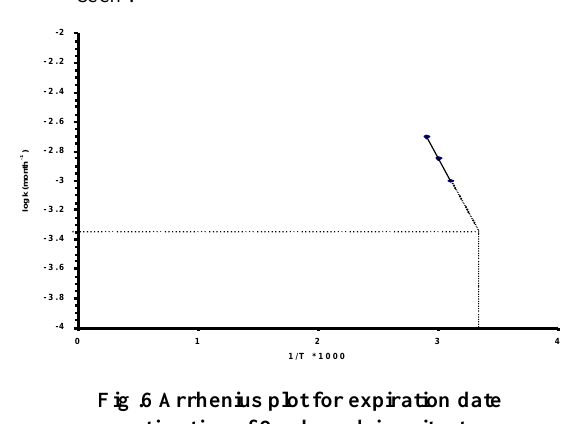
Fig .6 Arrhenius plot for expiration date estimation of Orphenadrine